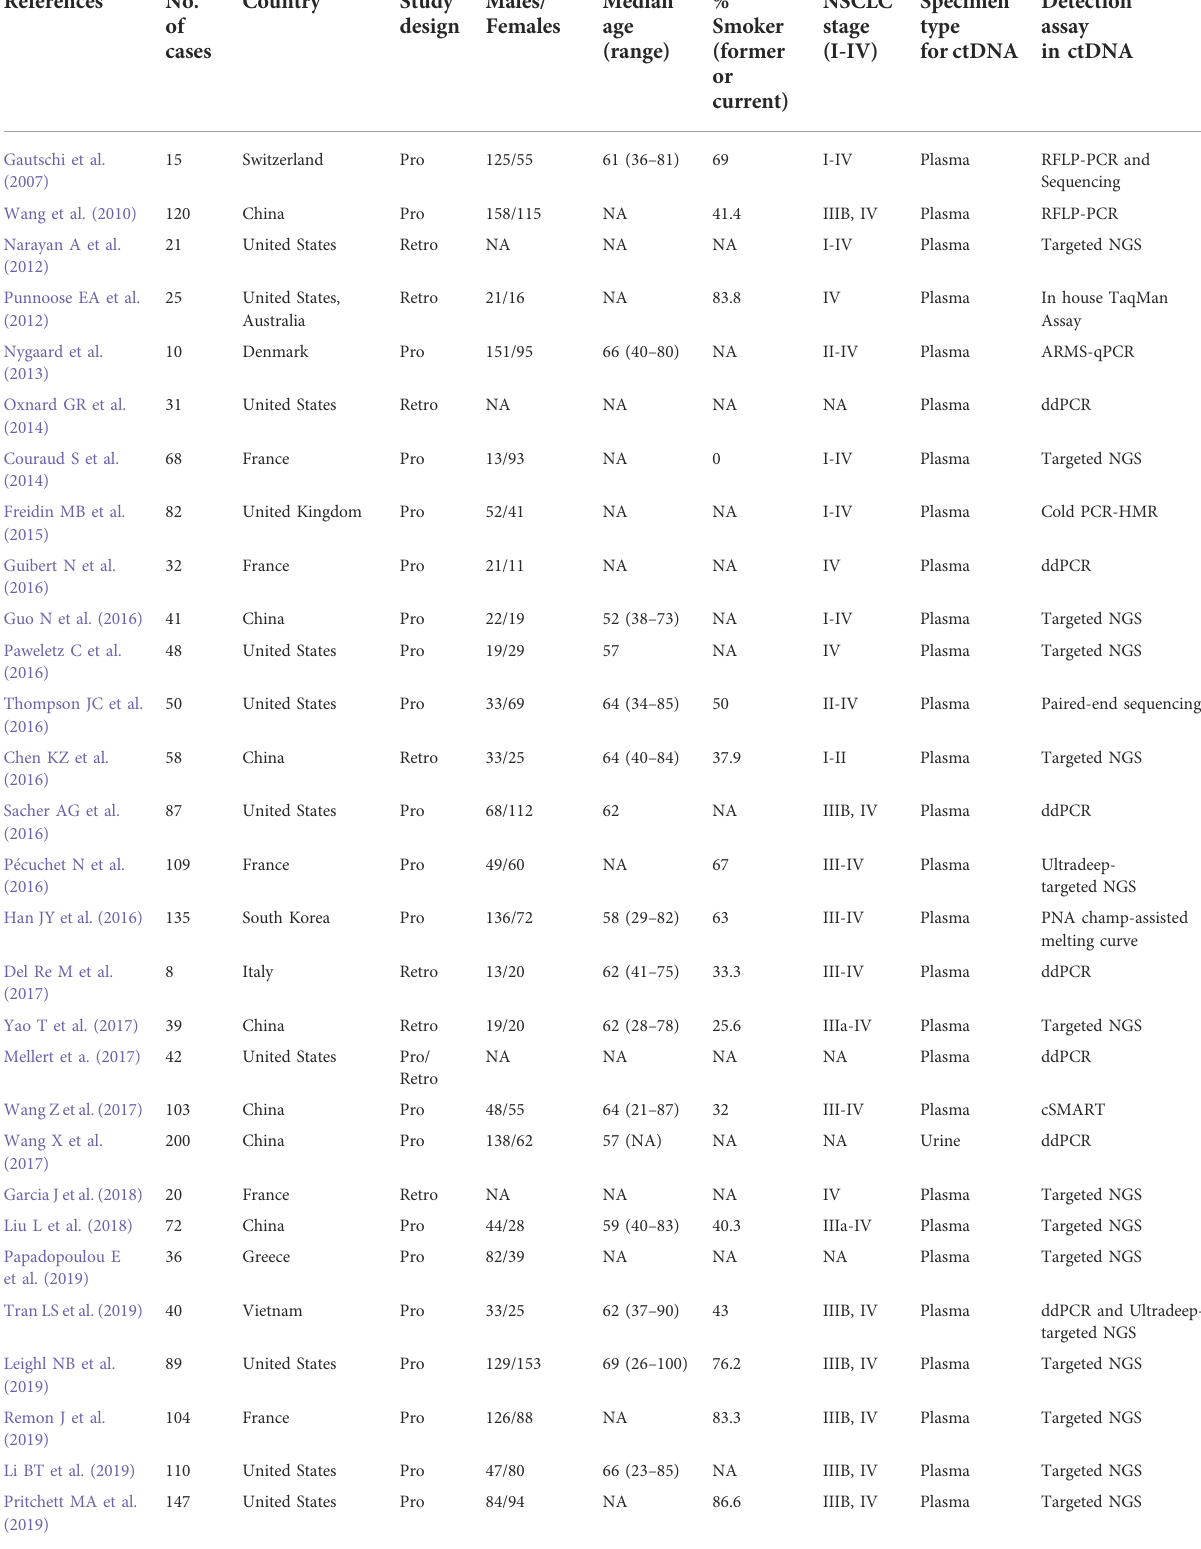
TABLE 1 Characteristics of eligible studies included in the meta- and